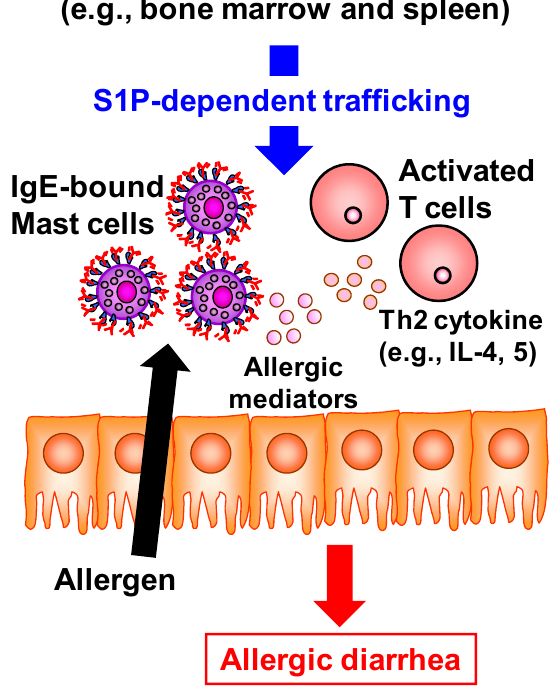
Figure 4. S1P mediates intestinal allergy by regulating pathogenic T and mast